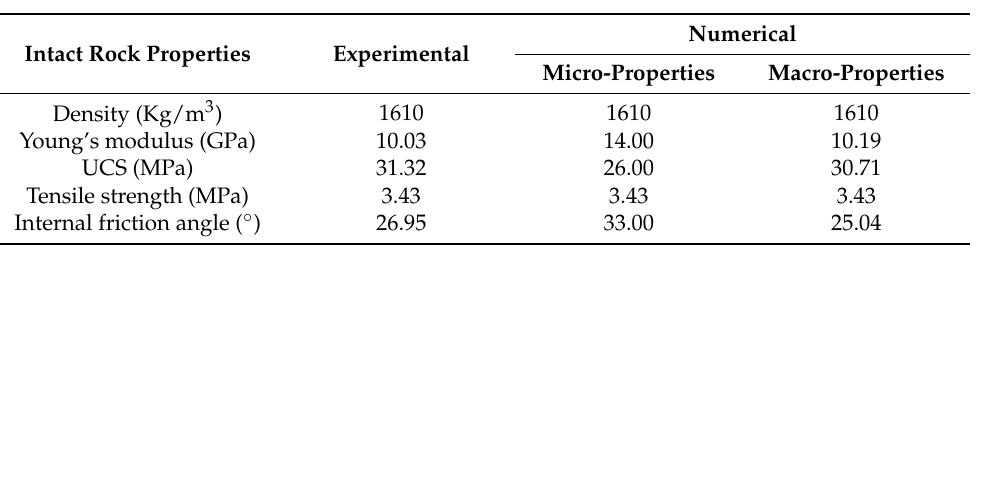
Figure 6. A schematic of the intact rock UCS & TCS calibration procedure for the LS-SRM model. Table 2. Experimental and numerical mechanical properties of the rock-like material.